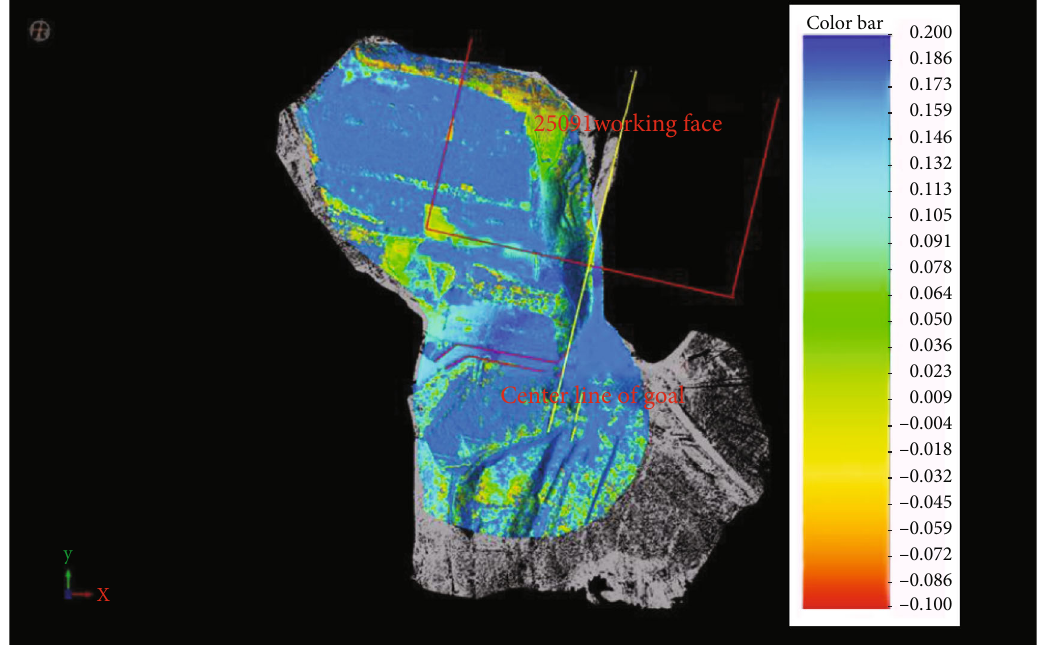
Figure 9: Comparison of point cloud DEM in the second and fi rst